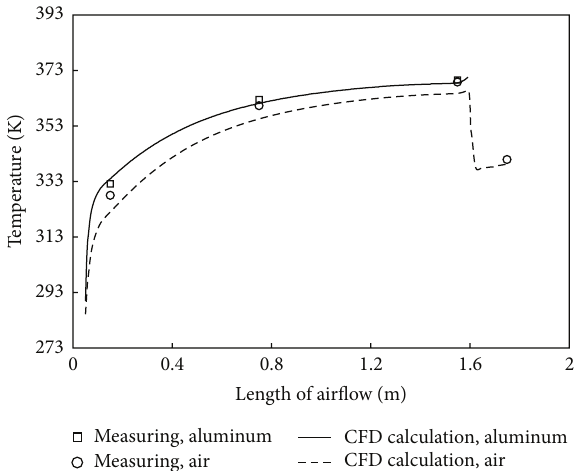
Figure 5: Air temperature comparison between measured and calculated results under free